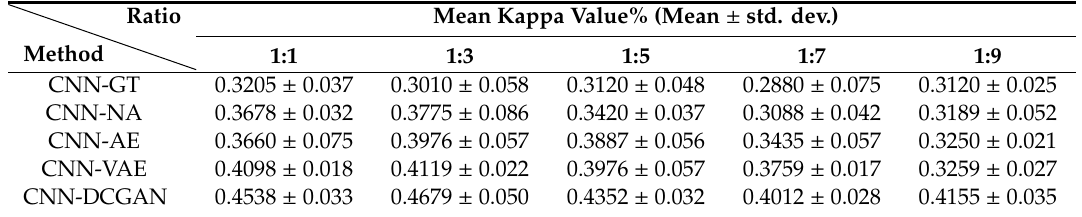
Table 8. Mean kappa values of the methods for the BCI competition IV dataset 1 (baseline: 0.4018 ± 0.048%). Ratio Method